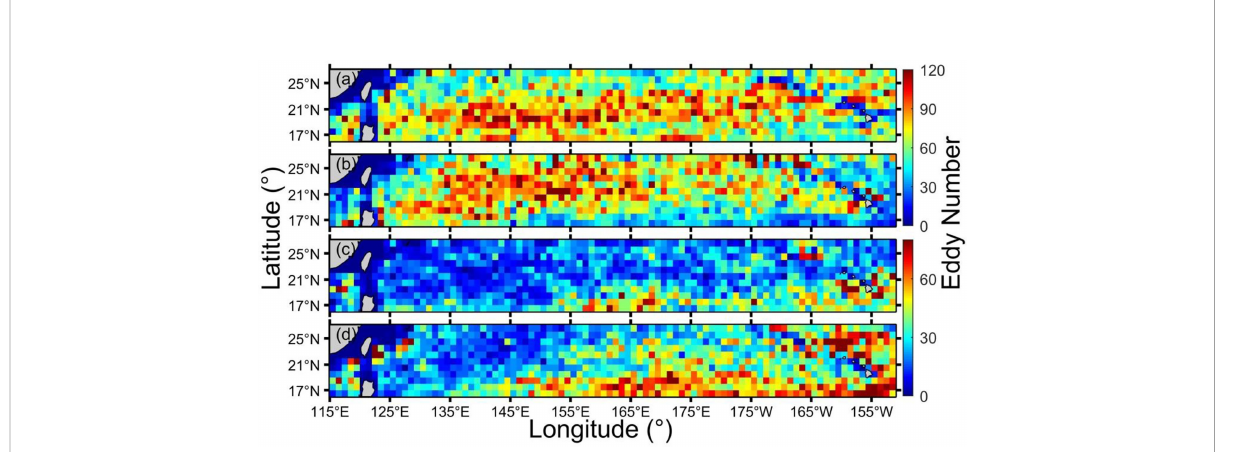
FIGURE 3 Number of four types of eddies at the sea surface in the STCC region in each 1° by 1° grid. (A – D) show cyclonic cold-core eddy, anticyclonic warm-core eddy, cyclonic warm-core eddy, and anticyclonic cold-core eddy, respectively. The color indicates the number of eddies. Note that (A, B) and (C, D) use different color bar